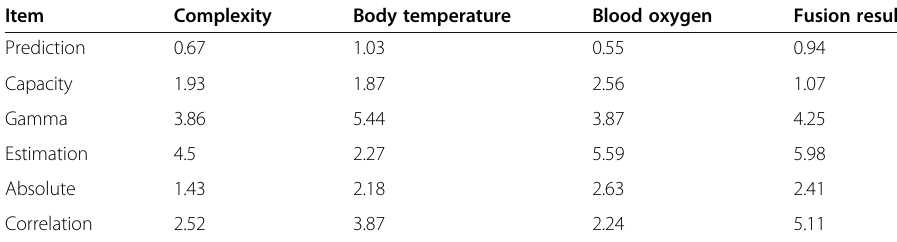
Table 6 The complexity of prediction model and algorithm